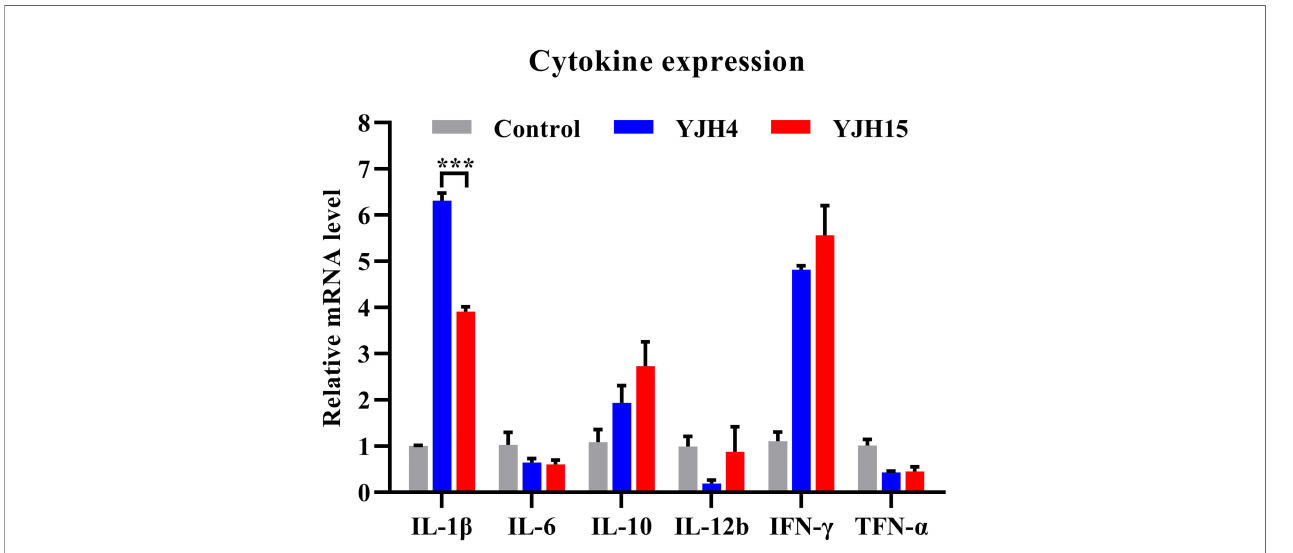
FIGURE 3 | Expression levels of blood cytokine in mice infected with K. pneumoniae YJH4 and YJH15. Expression levels of cytokines produced in murine blood recorded after infection with K. pneumoniae YJH4 and YJH15 for 24 hours by quantitative real-time PCR (n = 4). Mice injected with normal saline were included as normal control. Data were presented as the mean ± SD of four independent cDNA samples and analyzed by the unpaired t test (*** P = 0.0007).